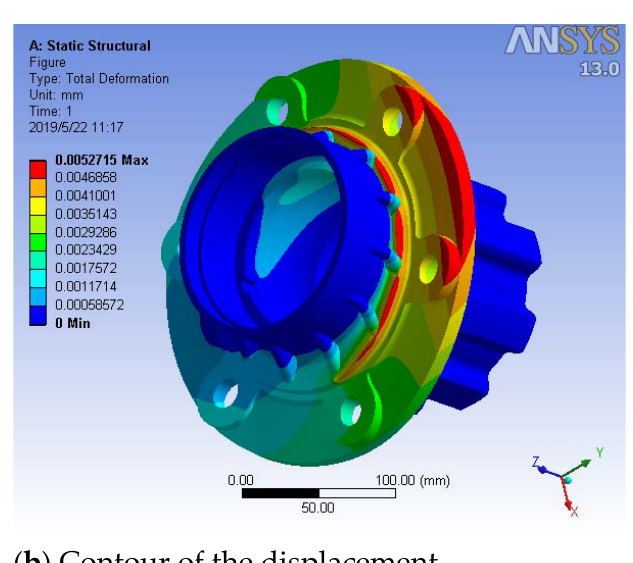
Figure 7. Finite element analysis results.